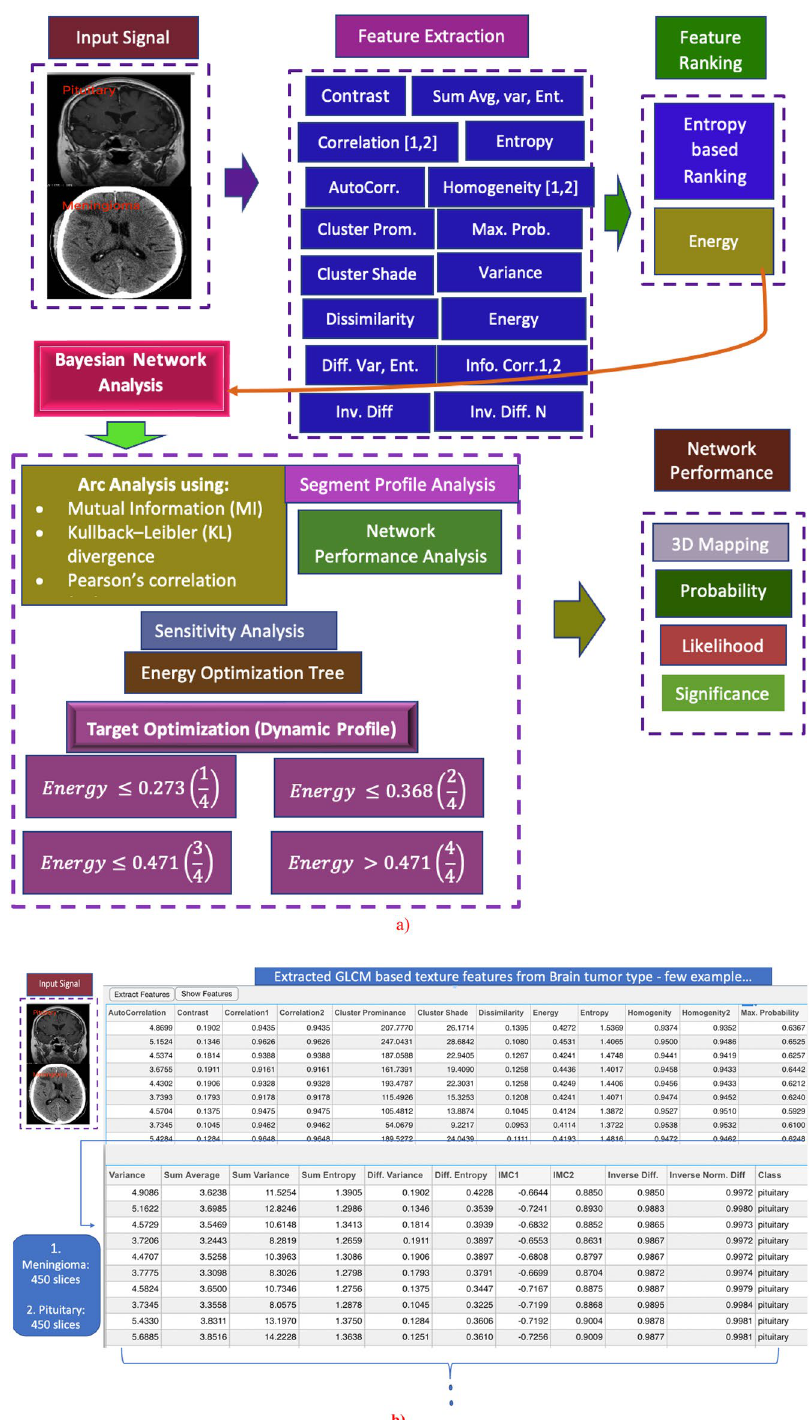
Figure 1. Schematic diagram based on Bayesian inference analysis on target node based on extracted GLCM based